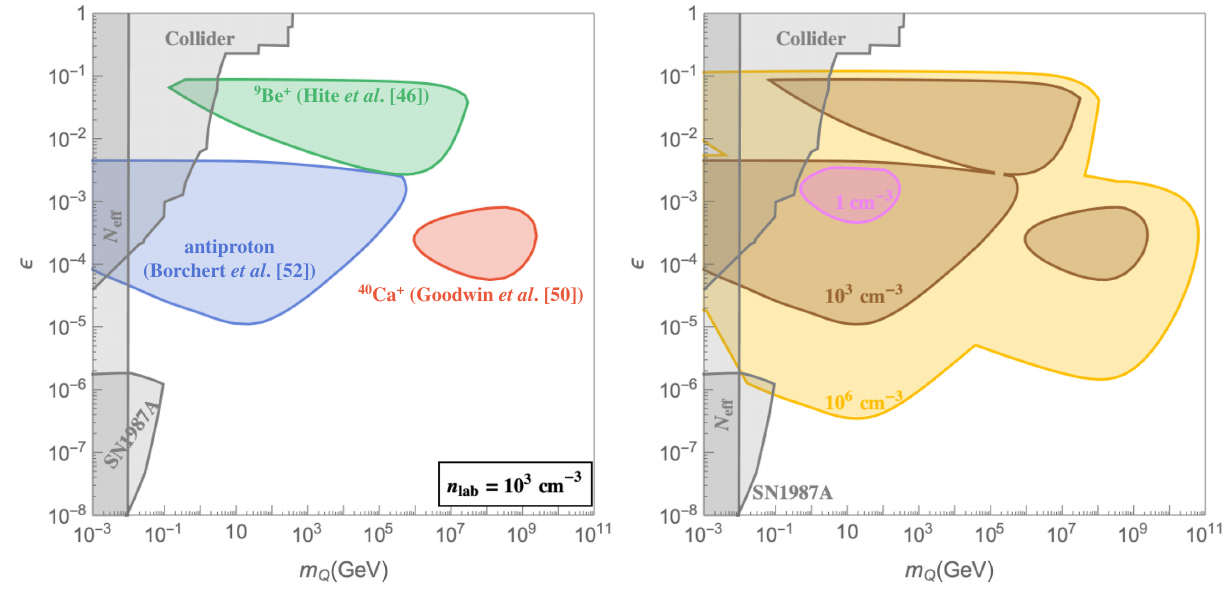
FIG. 2. A compilation of new limits [the shaded areas are where the parameters are excluded at the > 95% confidence limit (CL)] using existing heating measurements from various traps in Table I: a room-temperature Paul trap, from Hite et al. [46] ( ω z mode); a room-temperature Penning trap, from Goodwin et al. [50] ( ω z mode); and a cryogenic Penning trap, from Borchert et al. [52] ( ω − mode). Left: a comparison between traps for a benchmark ambient density n lab = 10 3 cm − 3 . Right: combined limits from the three traps for different n lab . Limits on the virial dark matter fraction are shown in Fig. 4. Existing limits on mCPs (with no assumption on the DM fraction) are shown in gray. The collider limits are obtained from Refs. [2–7], the SN1987A limits from Ref. [13], and the big bang nucleosynthesis N eff limits from Ref.